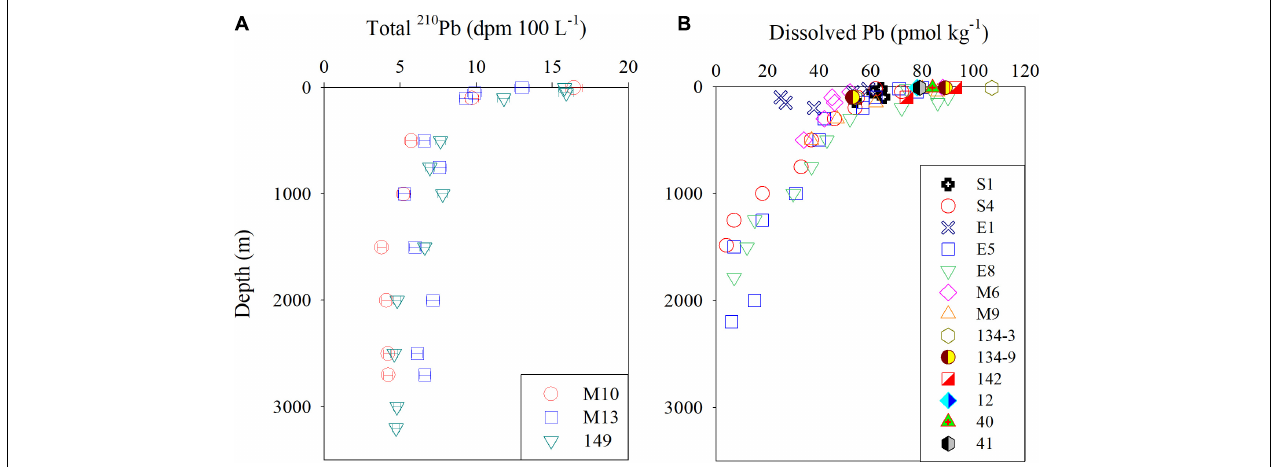
Henderson and Maier-Reimer, 2002; Hirose et al., 2004; Yi et al., 2007; Akata et al., 2008; Du et al., 2008, 2015; Tateda and Iwao, 2008; Table 1 ). It is reasonable to assume that the atmospheric input of 210 Pb calculated from the 210 Pb budget in the ocean